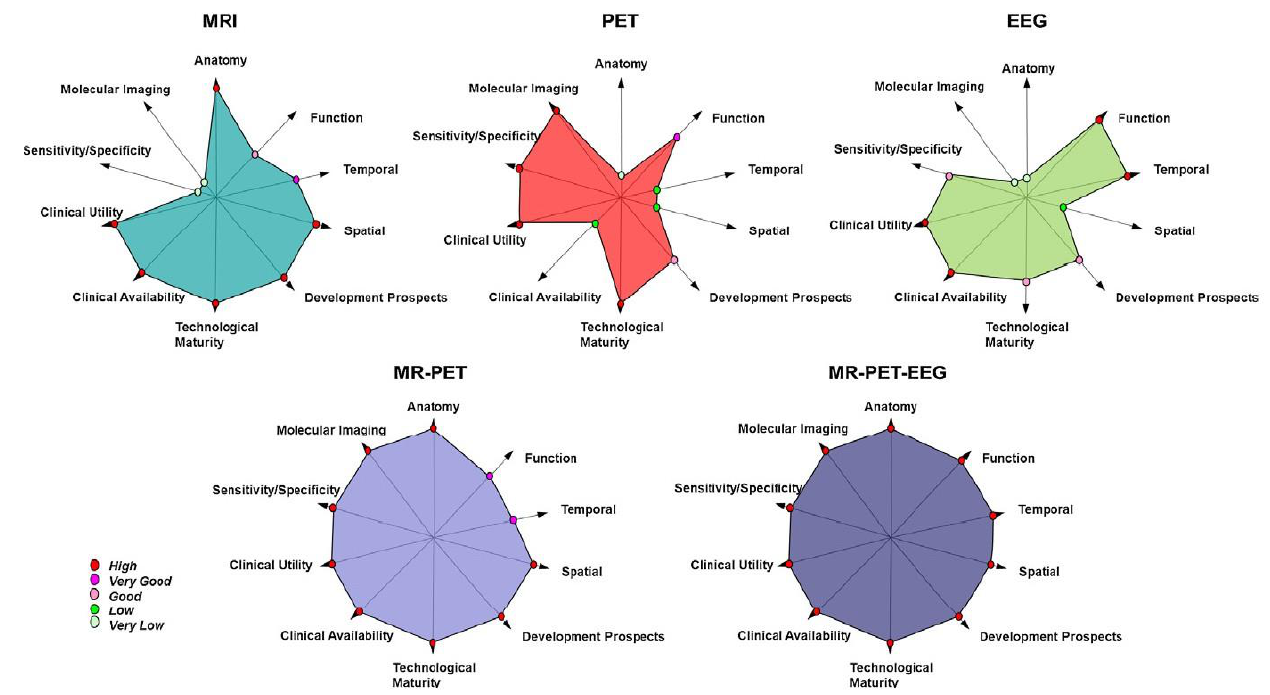
Figure 11. Fingerprint diagrams giving an overview of the strengths of MRI, PET, EEG, hybrid MR–PET, and hybrid MR–PET–EEG. Starting at the origin, the further one traverses along a given axis, the better that particular attribute is fulfilled. MRI can provide exquisite spatial resolution and the technology is widely available; however, MRI is not strong in the area of molecular imaging and its specificity is also somewhat limited. PET on the other hand, has poorer spatial and temporal resolution than MRI but it is extremely specific—an attribute conferred upon it by the choice of radiolabelled tracer—and is also very sensitive. Both MRI and PET have a poor temporal resolution regarding the mapping of brain function, for example. In a hybrid scanner capable of simultaneous measurement of all three datasets, all the chosen attributes are fulfilled in entirety. Reproduced with permission from Ref. [160]. Copyright 2013 Elsevier.